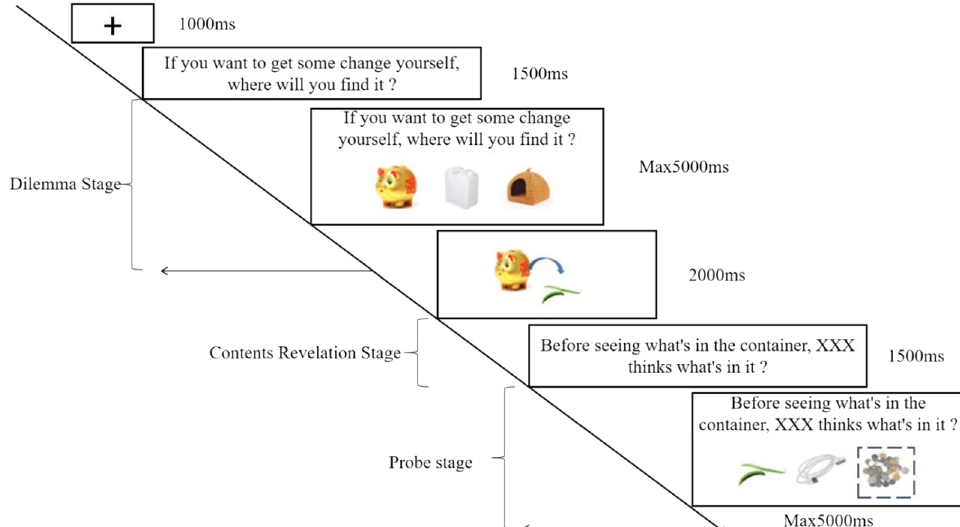
Fig. 1 Flowchart of single trial under unexpected conditions of Self/Other Differentiation Task. Note . Dilemma stage (self, others: Uygur, Han), contents revelation stage (expected, unexpected), probe stage (self, others: Uygur, Han). In our experiment, English in the original task was translated into Chinese, the followings were the same. For the convenience of reading, we have dotted the correct answers